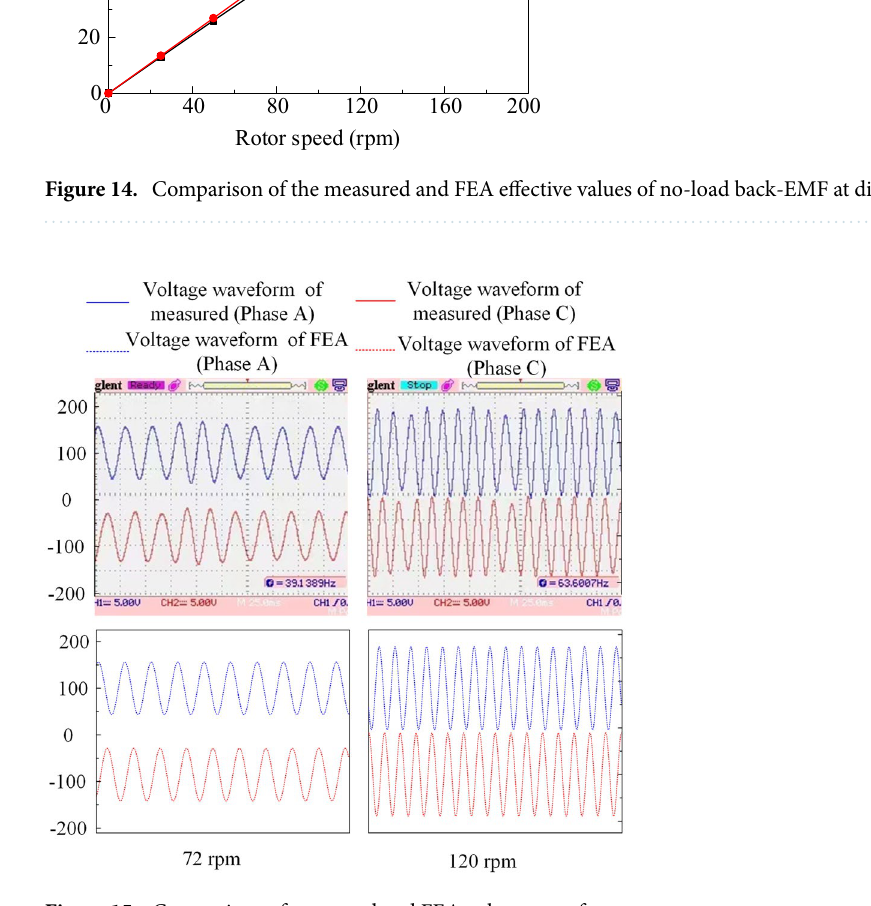
Figure 15. Comparison of measured and FEA voltage waveforms.